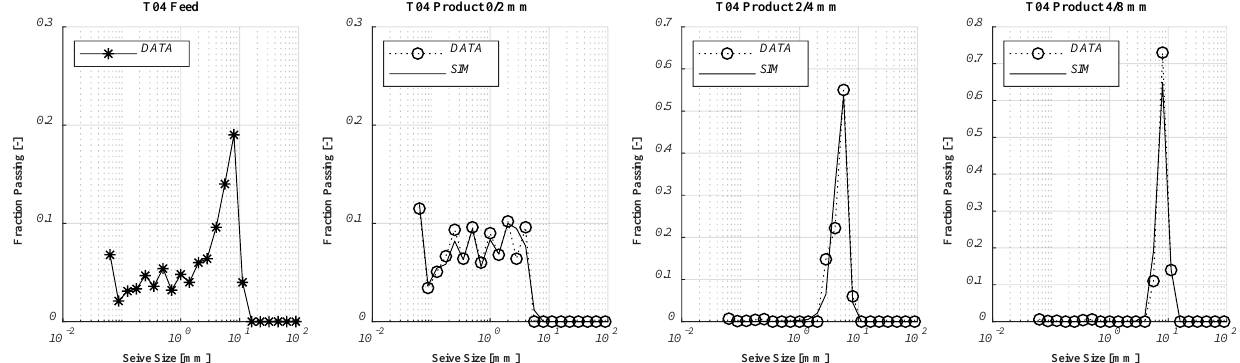
Figure A3. Screen 2 calibration results for T01 in the frequency domain.